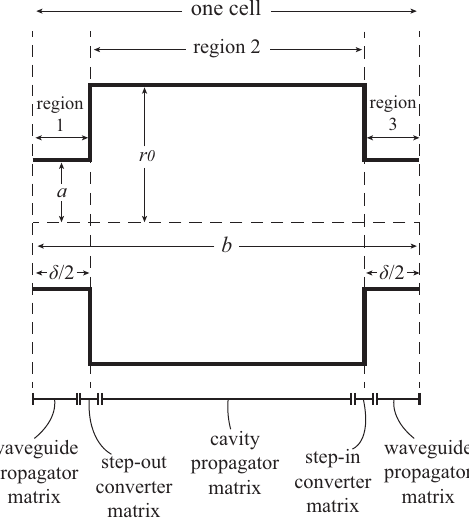
FIG. 8. A sketch illustrating how the different sections of the cell are modeled using different transmission matrices in the numerical